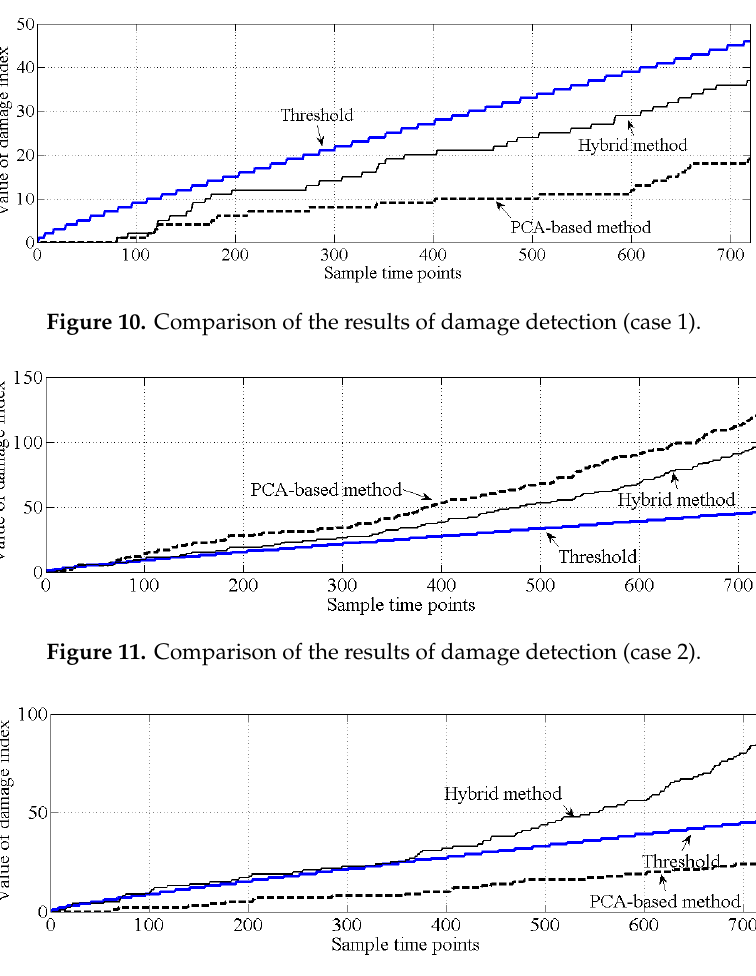
Figure 12. Comparison of the results of damage detection (case 3).